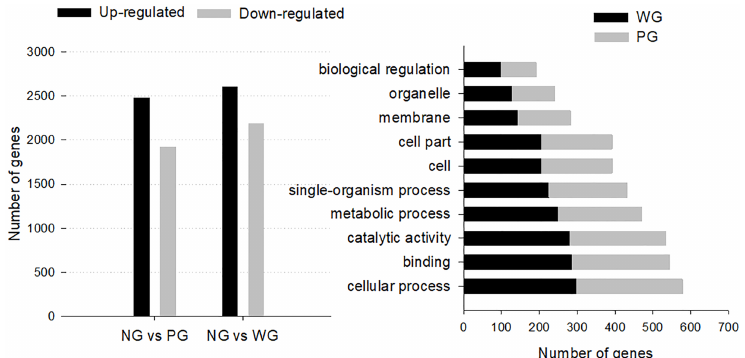
Fig 3. A, static of differentially expressed genes (DEGs) 48 h post infections of WSSV and poly I: C. B, functional distribution and Top 10 of the GO classification of